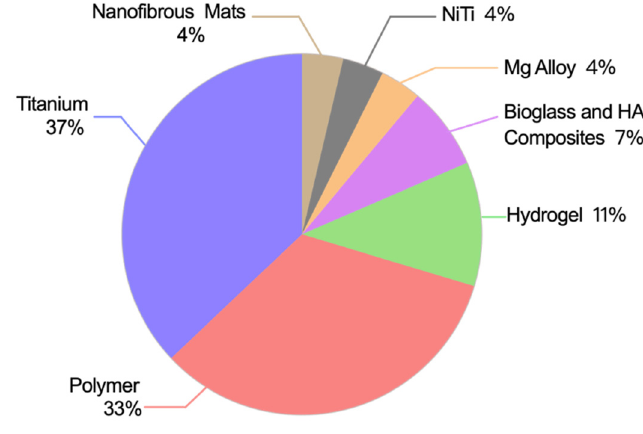
Figure 2. The varieties and numbers of substrate materials in publications.